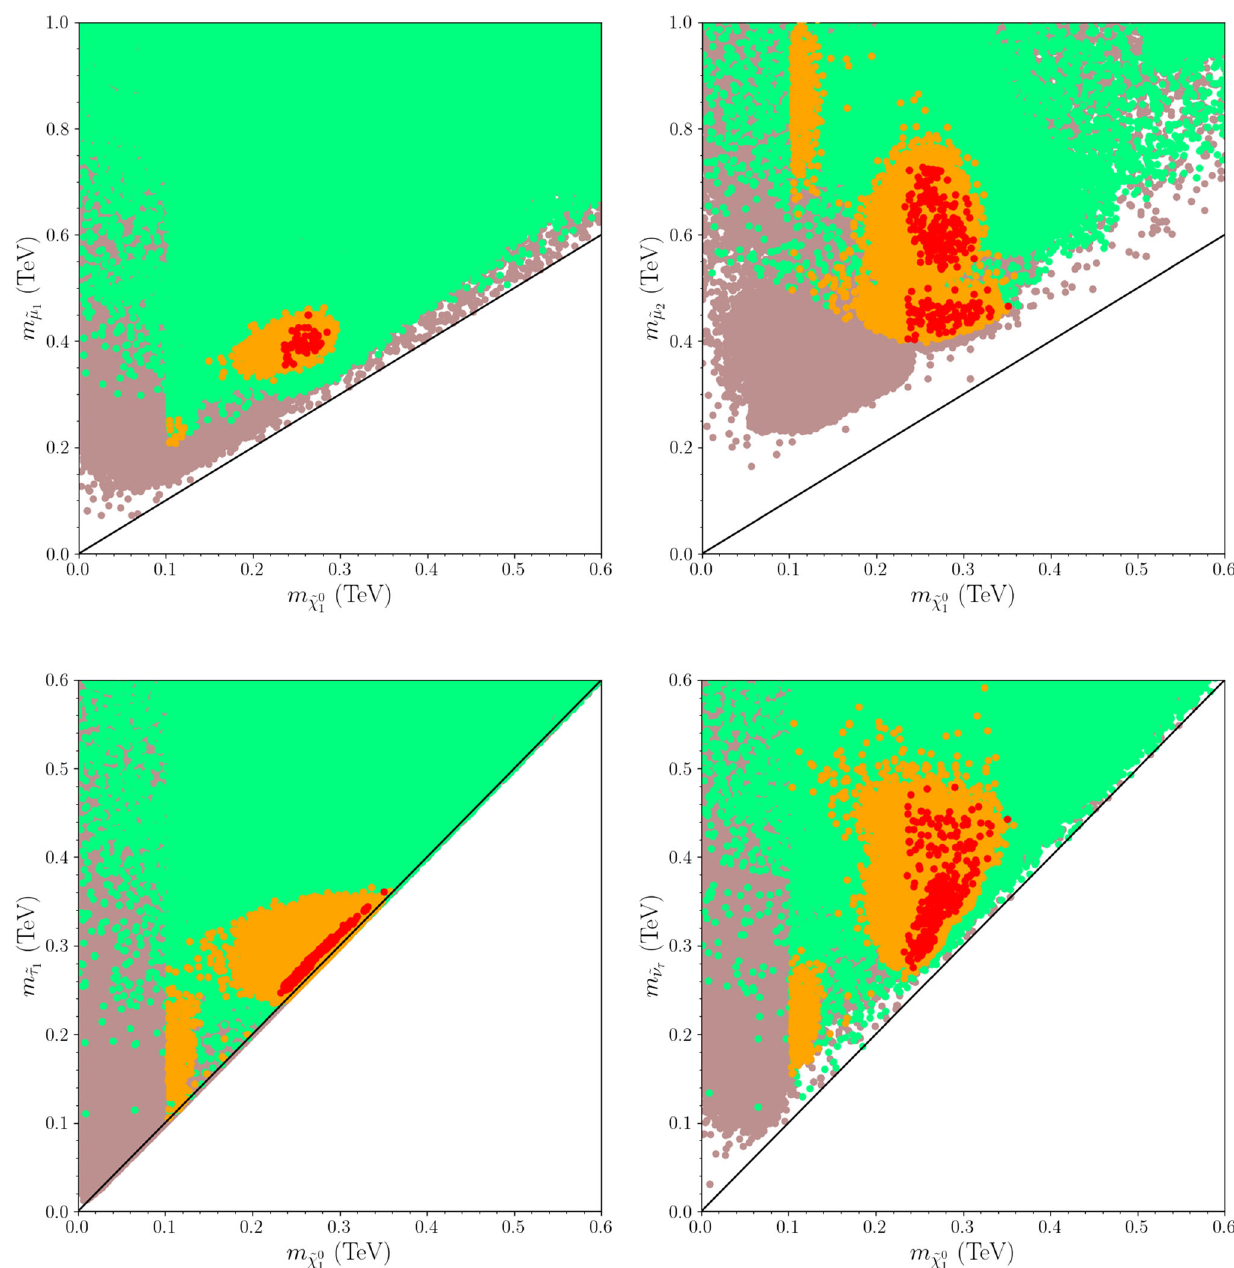
Fig. 8 Slepton spectrum with respect to the LSP neutralino mass in the m ˜ μ is the same as in Fig. 6. The diagonal lines show the mass degeneracy between the plotted SUSY particles. The black curve in the m ˜ τ